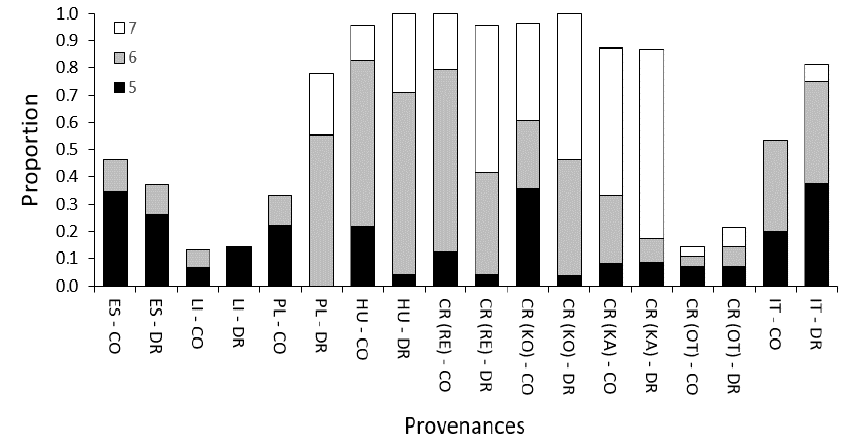
Figure 6. Proportions of plants in advanced flushing phases at the time of the frost event on 21st April 2017 by provenance and treatment: 5 (leaf unfolding but not yet flattened, small), 6 (leaves still relatively small but with flattened blades, blade edges bent downwards, withered, lighter green or reddish), and 7 (leaves completely developed, larger but still more tenderly structured (thinner) than fully developed leaves and lighter green or reddish). CO—control; DR—drought treatment.